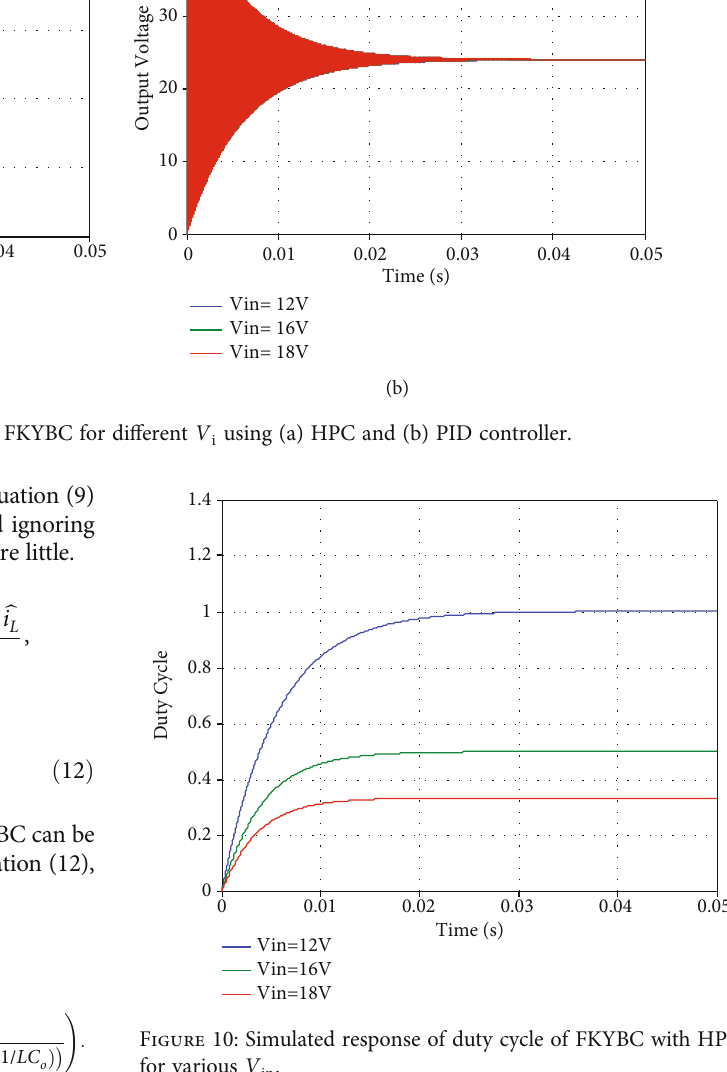
Figure 10: Simulated response of duty cycle of FKYBC with HPC for various V in